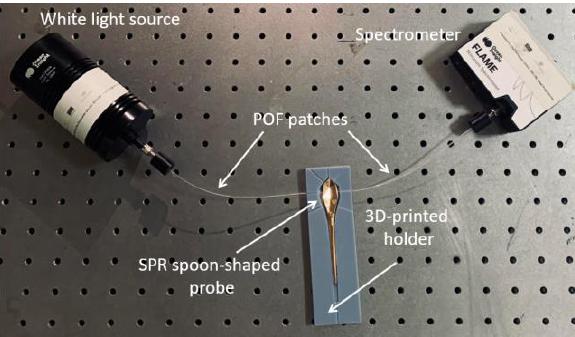
Figure 2. Experimental setup used to test the SPR spoon-shaped platform in orthogonal interrogation mode [27].